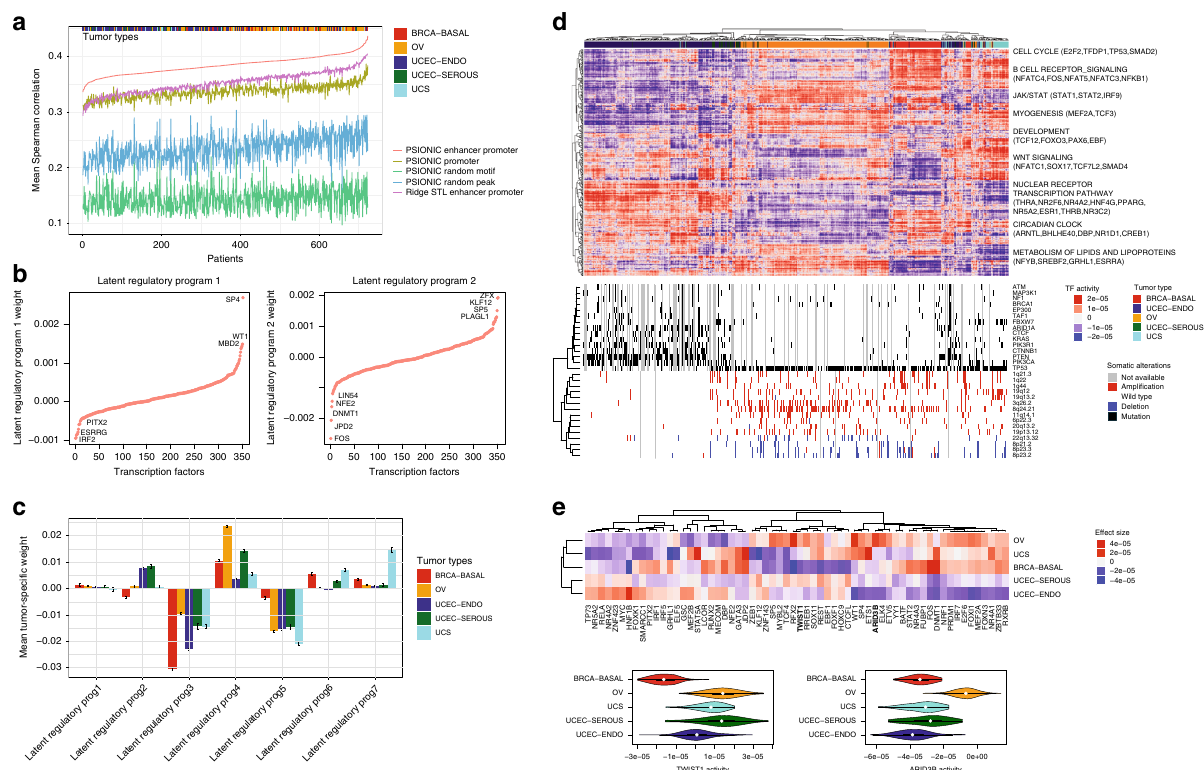
Fig. 3 PSIONIC identi fi es regulatory features of tumor types. a PSIONIC and STL regression models predict differential expression of held-out genes and subtypes of tumor samples. Plot showing Spearman correlations between predicted and actual gene expression changes for all samples, sorted based on performance of the PSIONIC model using enhancer and promoter TF-binding sites. For each method and each sample, the Spearman correlation is computed using 10-fold cross-validation on held-out genes. Using TF-binding sites from enhancer promoter as features (mean ρ = 0.384 ± 0.016) is signi fi cantly better than if we randomized motif hits for each chromatin accessible region across all motifs (mean ρ = 0.144 ± 0.022; P < 10 − 32 , one-sided Wilcoxon signed-rank test), or if we randomized accessible regions for each motif, then assigned to the nearest gene (mean ρ = 0.235 ± 0.025; P < 10 − 32 , one-sided Wilcoxon signed-rank test). PSIONIC models with motif data from promoter and enhancer regions outperformed models where only motif hits in promoter regions were used (mean ρ = 0.337 ± 0.012; P < 10 − 16 , one-sided Wilcoxon signed-rank test) and STL approach based on ridge regression (mean ρ = 0.352 ± 0.019; P < 10 − 21 , one-sided Wilcoxon signed-rank test). TCGA tumor types are shown in the top bar. b Example of latent regulatory programs. TFs are ranked based on the magnitude of coef fi cients. Remaining latent regulatory programs are shown in Supplementary Fig. 6. c Mean (± SE, standard error) tumor weight matrix (denoted by S ) grouped according to tumor type for each latent regulatory program. d Hierarchical clustering mean-centered model vectors (denoted by W ) on the TCGA tumor data sets. Source data are provided as a Source Data fi le. e Heatmap shows the mean inferred TF activity differences between samples in a given tumor type vs. those in all other tumor types. For each comparison, the absolute value of the mean inferred TF activity differences (effect sizes) are ranked and the union of top 20 TFs for each comparison are shown in the heatmap. Violin plots indicate the distribution of inferred ARID3B and TWIST1 TF activities across tumor types. Source data are provided as a Source Data fi